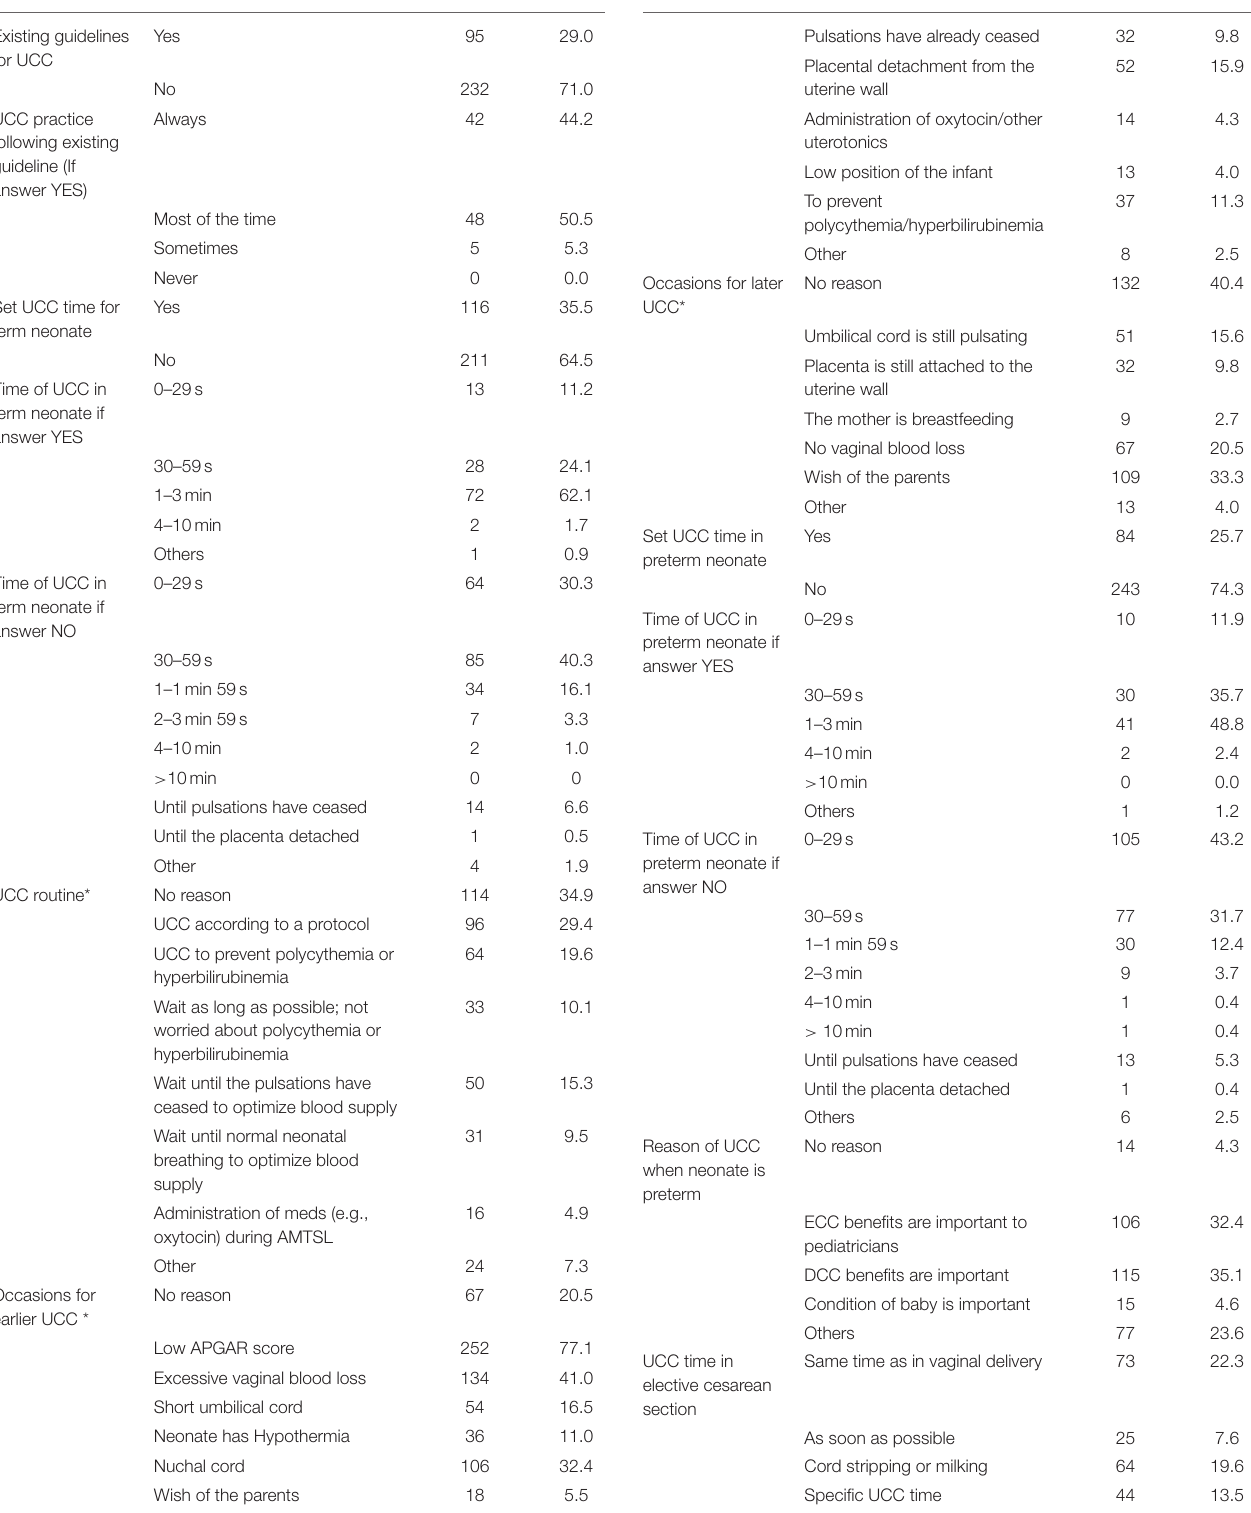
TABLE 2 | Existing umbilical cord clamping practices ( n =